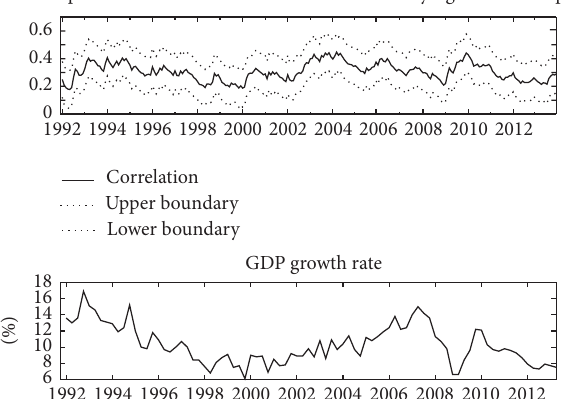
Figure 1: Conditional correlation in the time-varying Gaussian copula and Chinese GDP growth rate, with 95% confidence interval for the time-varying